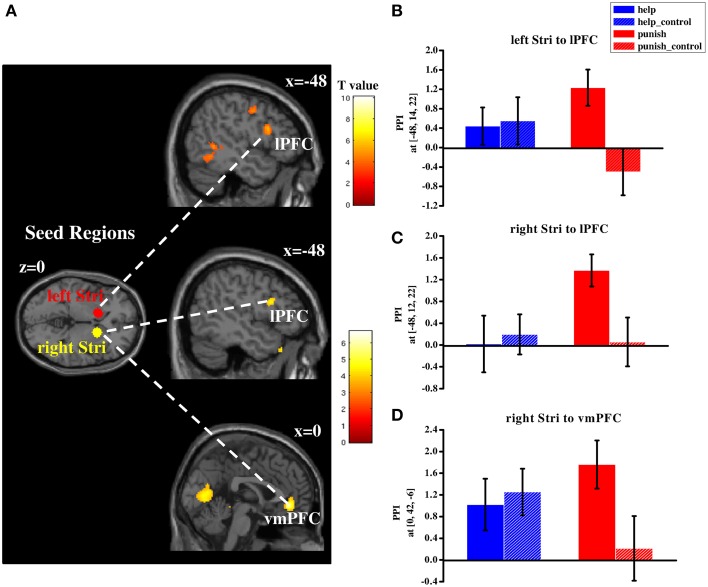
Regions showing increased functional connectivity with bilateral striatum during third-party punishment decisions (compared with control conditions; (A) and plots of parameter estimates of PPI in local peak voxel of left lPFC with left (B)/right (C) striatum and that of vmPFC with right striatum (D) in four conditions (i.e., help, help_control, punish, punish_control). PPI, psycho-physiological interaction; lPFC, lateral prefrontal cortex; vmPFC, ventral medial prefrontal cortex; Stri, striatum; Error bars: SEM.